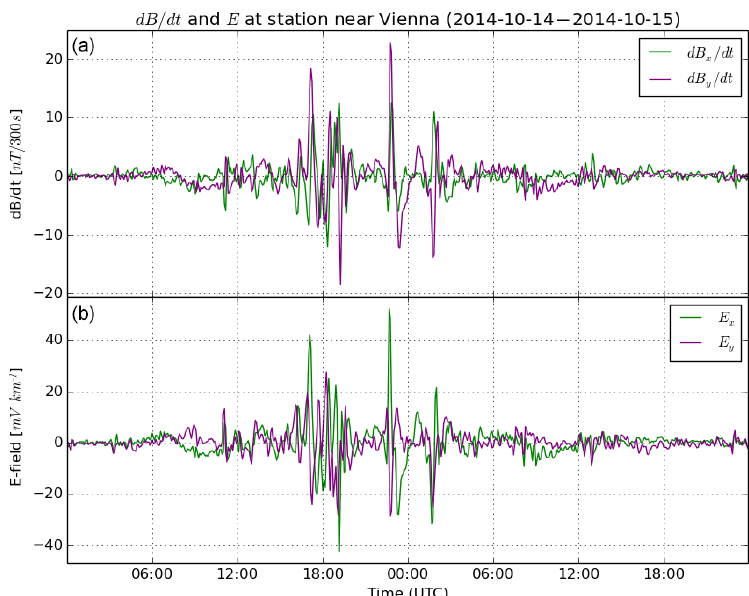
Figure 4. (a) Change in the horizontal geomagnetic field at the Conrad Observatory ( x and y components) per period of 300s for the days of 14 and 15 October 2014. Change in the x direction is in green; change in the y direction is in purple. (b) Modelled geoelectric field for the area near Vienna on the days of 14 and 15 October 2014. The field in the north–south direction (Ex) is plotted in green; the east–west direction (Ey) is plotted in